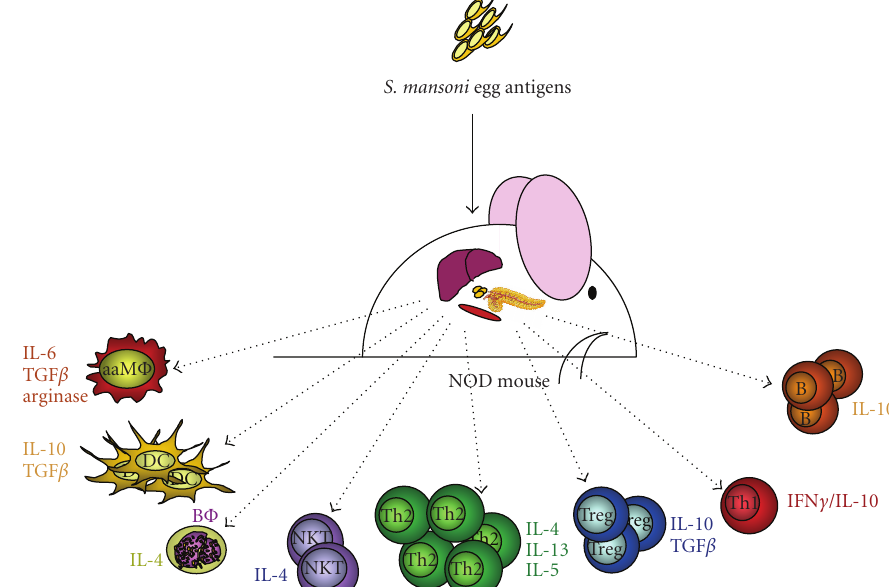
Figure 7: The cellular immune response to S. mansoni egg antigens in NOD mic: alternative activation of M Φ s (aaM Φ s), maintenance of dendritic cells (DCs) in an immature phenotype, IL-4 release from basophils (B Φ s), expansion of classical natural killer T cells (NKT), expansion of T helper 2 (Th2) responses, expansion and activation of T regulatory cells (Tregs), as well as induction of IL-10 production in Th1 cells (Th1) and B cells